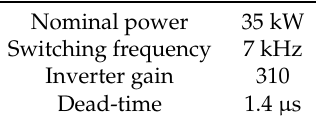
Table A4. Rating of the power converter